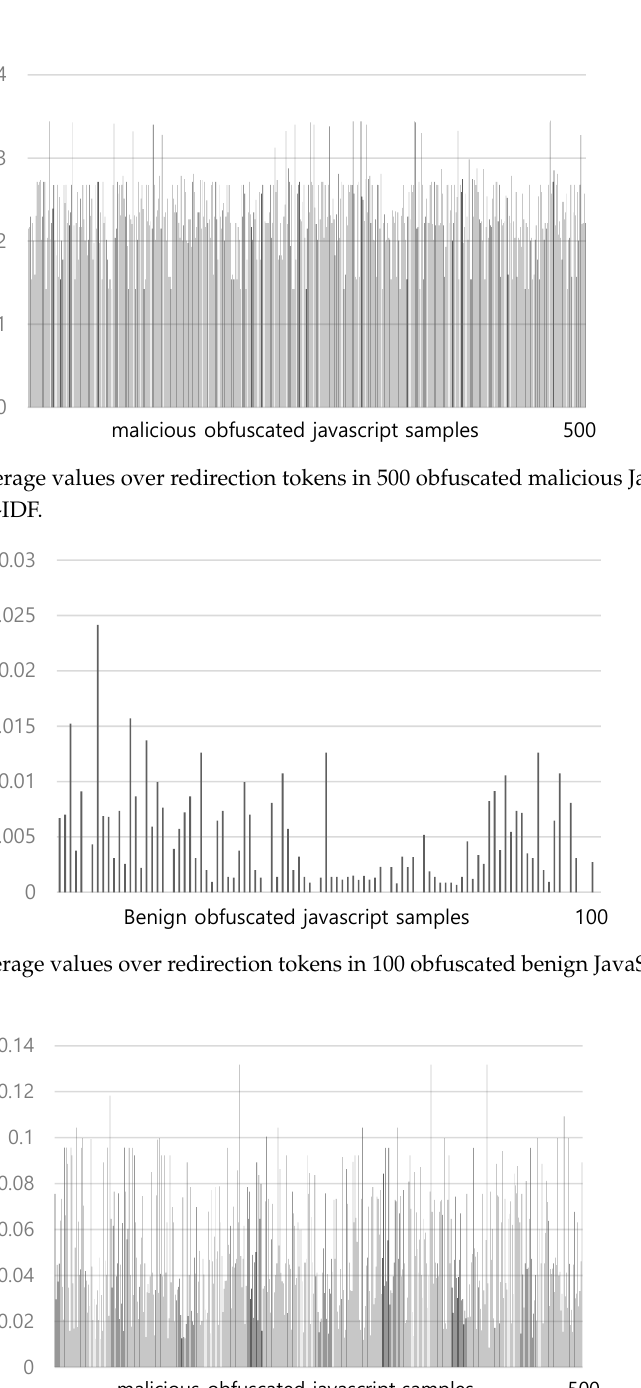
Figure 7. TF-IDF average values over redirection tokens in 100 obfuscated benign JavaScripts using the conventional TF-IDF.